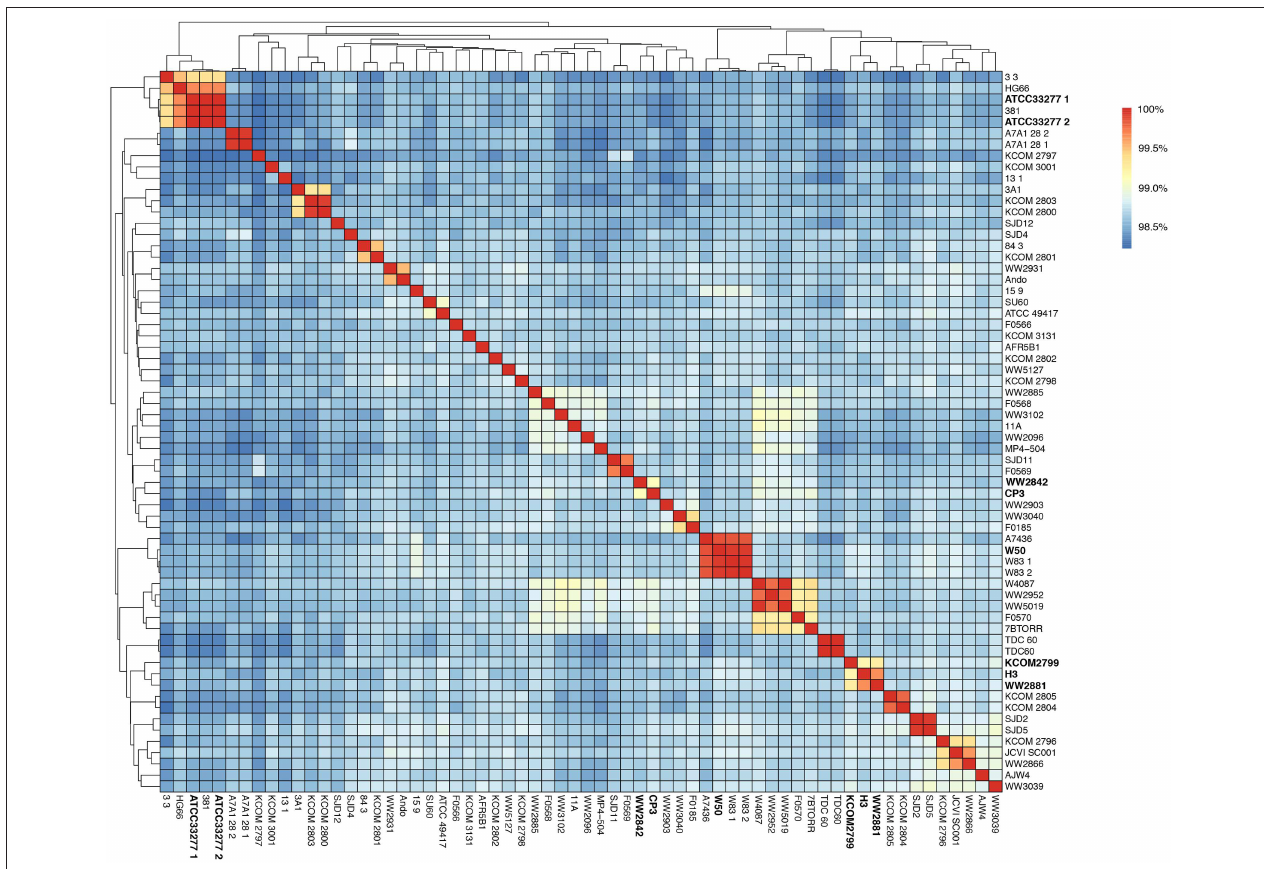
FIGURE 1 | Average nucleotide identity (ANI) in the 64-genome Porphyromonas gingivalis dataset. Hierarchical clustering of the P. gingivalis genomes based on their average nucleotide identity values. The color gradient from blue to red shows the percentage of identity, from lowest to highest, that each pair of genomes shares.